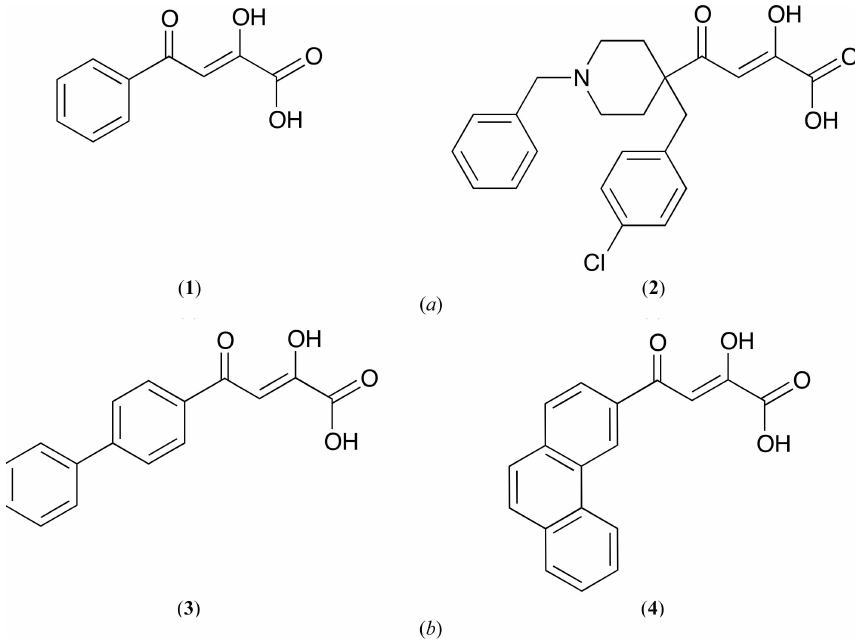
Figure 1 Structures of 2,4-dioxo-4-phenylbutanoic acid [DPBA, ( 1 )], ( Z )-4-{1-benzyl-4-[(4-chlorophenyl)- methyl]piperidin-4-yl}-2-hydroxy-4-oxobut-2-enoic acid [L-742,001, ( 2 )], 2-hydroxy-4-(biphenyl-4- yl)-4-oxobut-2-enoic acid ( 3 ) and 2-hydroxy-4-oxo-4-(phenanthren-3-yl)but-2-enoic acid ( 4